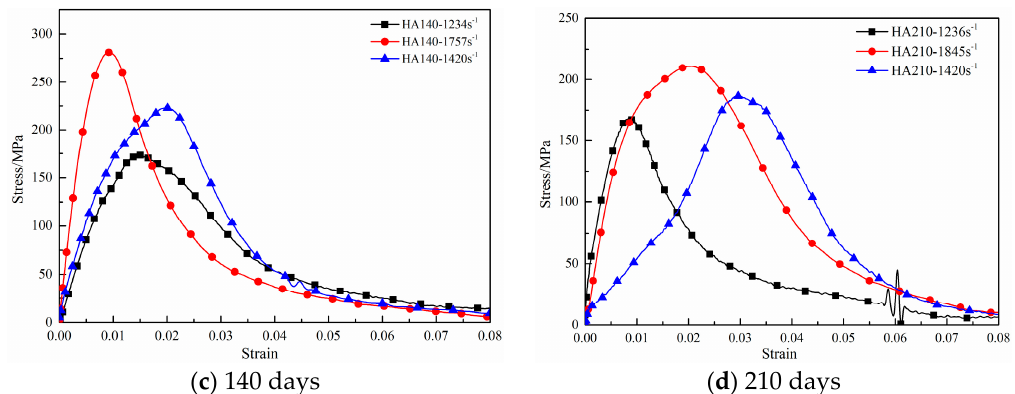
Figure 14. Dynamic compressive stress vs. strain curves for the 3D four-step braided composites after different hygrothermal aging days, ( a ) 14 days, ( b ) 70 days, ( c ) 140 days, ( d ) 210 days.